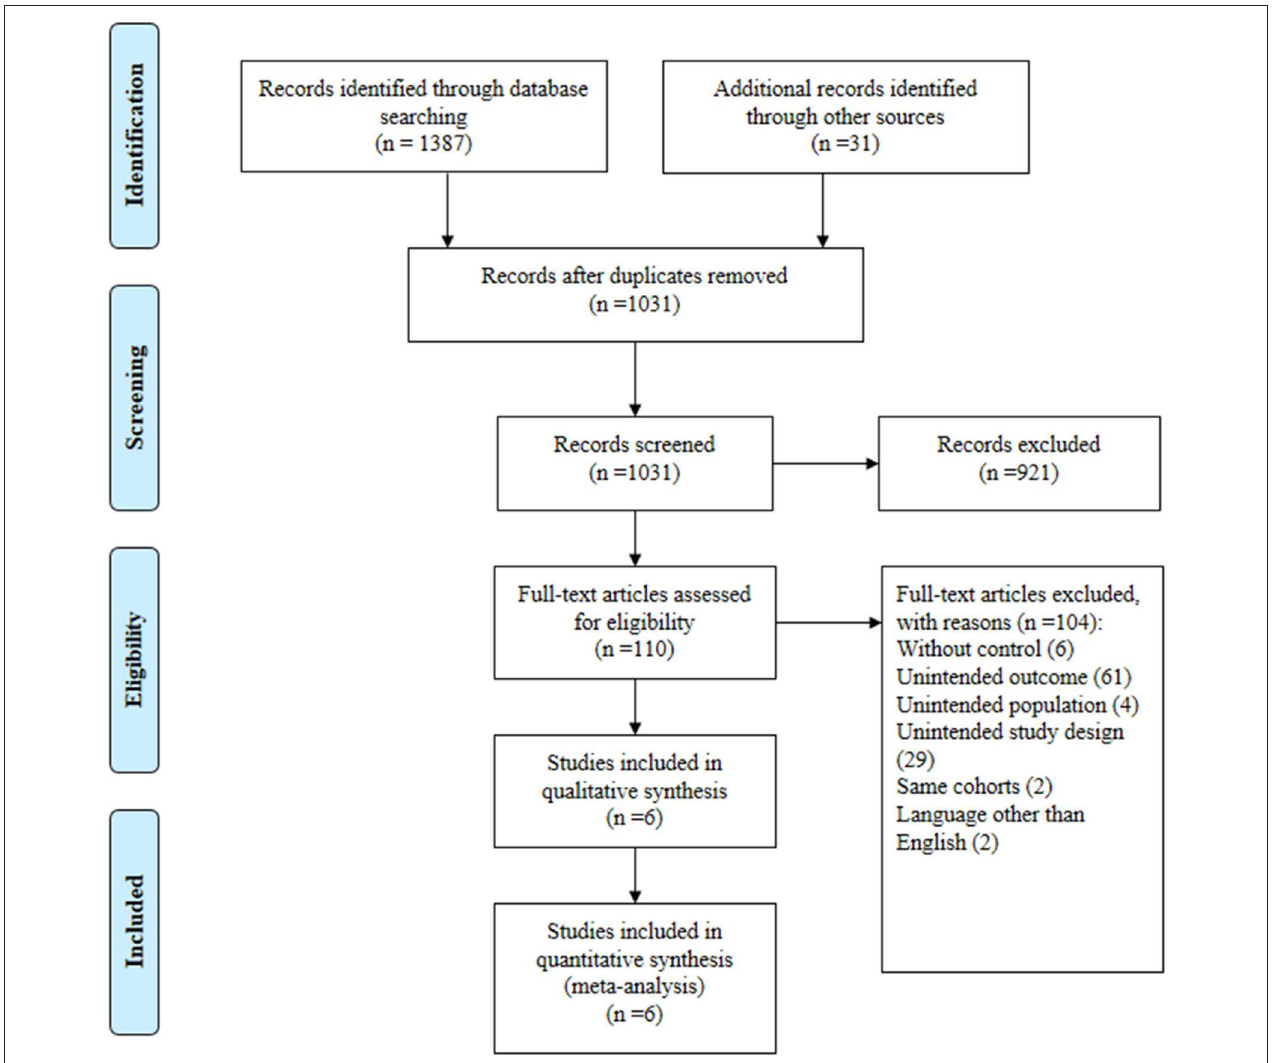
FIGURE 1 | Flow plot of literature